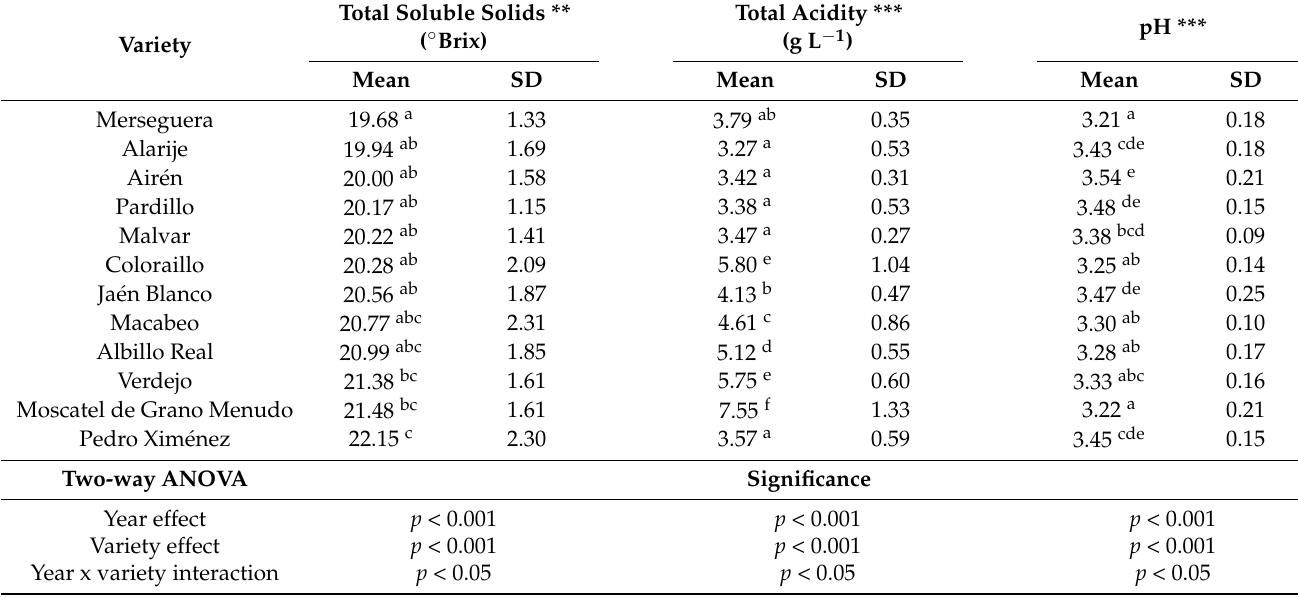
Table 4. Must quality parameters (mean value and standard deviation, n = 15) of 12 white